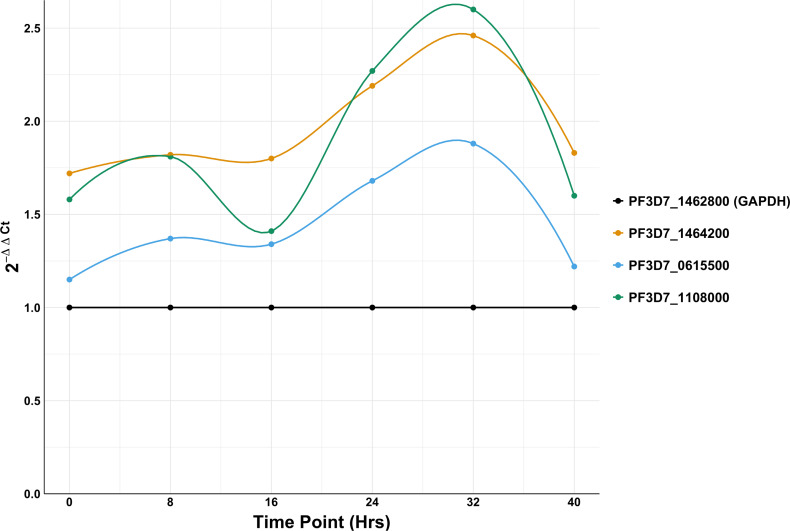
Time course mRNA expression analysis of three genes (PF3D7_1464200, PF3D7_0615500, PF3D7_1108000) containing polyA stretches of varying lengths (largest: 20, 20, and 31 adenosines respectively) normalized to GAPDH (PF3D7_1462800) starting with highly synchronized rings at time zero.2-ΔΔCt values represent mRNA abundance enrichment of genes with polyA stretches over PfGAPDH mRNA levels.